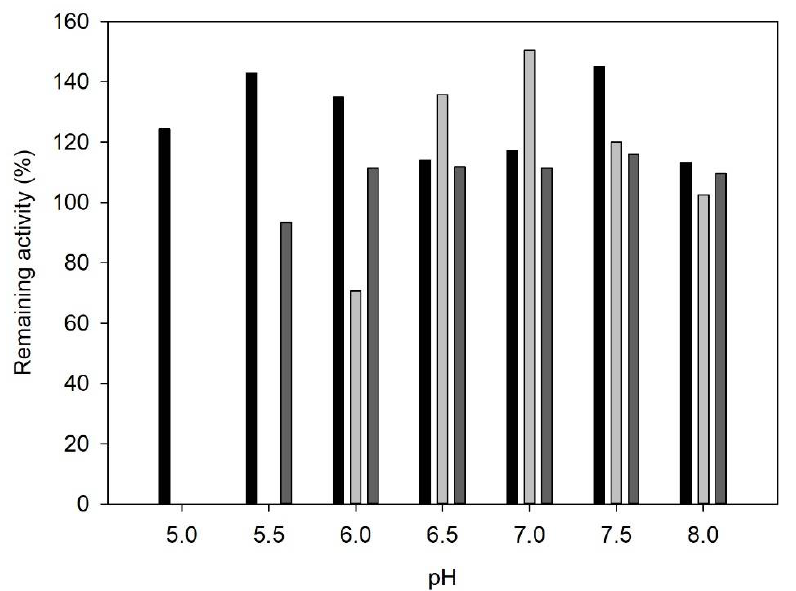
Figure 3. pH stability profile of PDC (black bars), CviTA (light grey bars), and VflTA (dark grey bars). Assay conditions: citrate buffer 100 mM (pH 5–6), potassium phosphate buffer 100 mM (pH 6.5–8), 25°C, mild agitation, 8 h. Table 1. Transaminase screening for 3-APB synthesis. Reaction conditions: 24 h; 30 ◦ C;